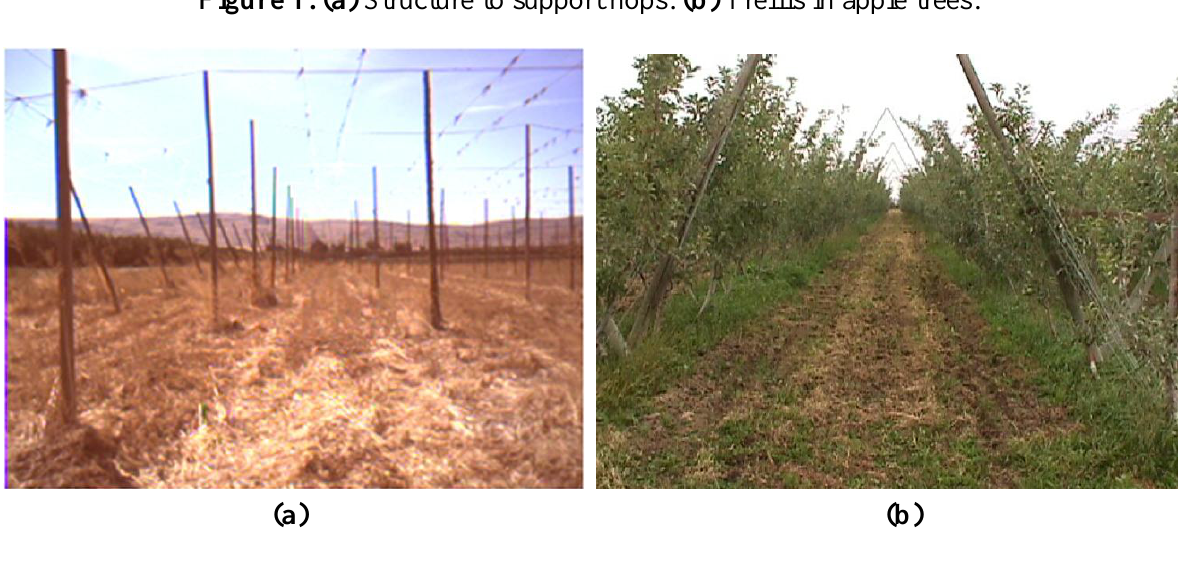
Figure 1. (a) Structure to support hops. (b) Trellis in apple